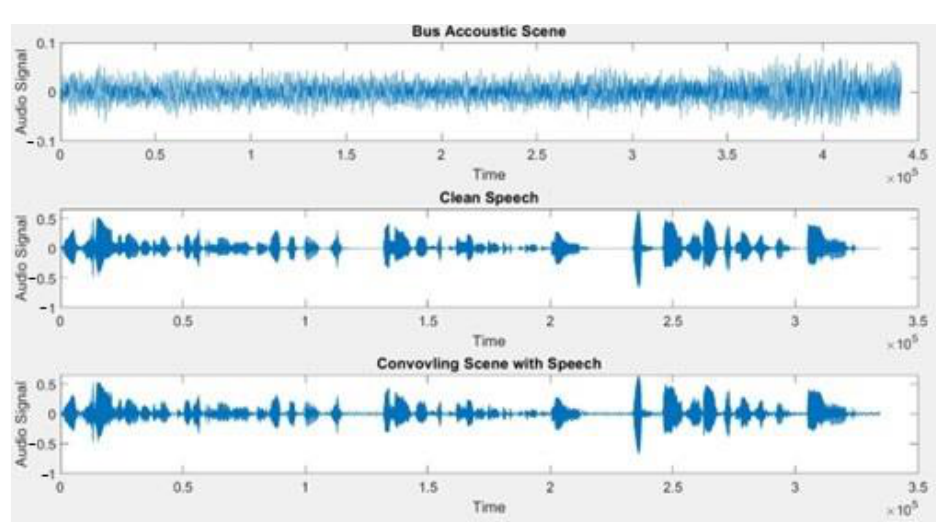
Figure 7. Scene, speech, and convolved signal of scene with speech.